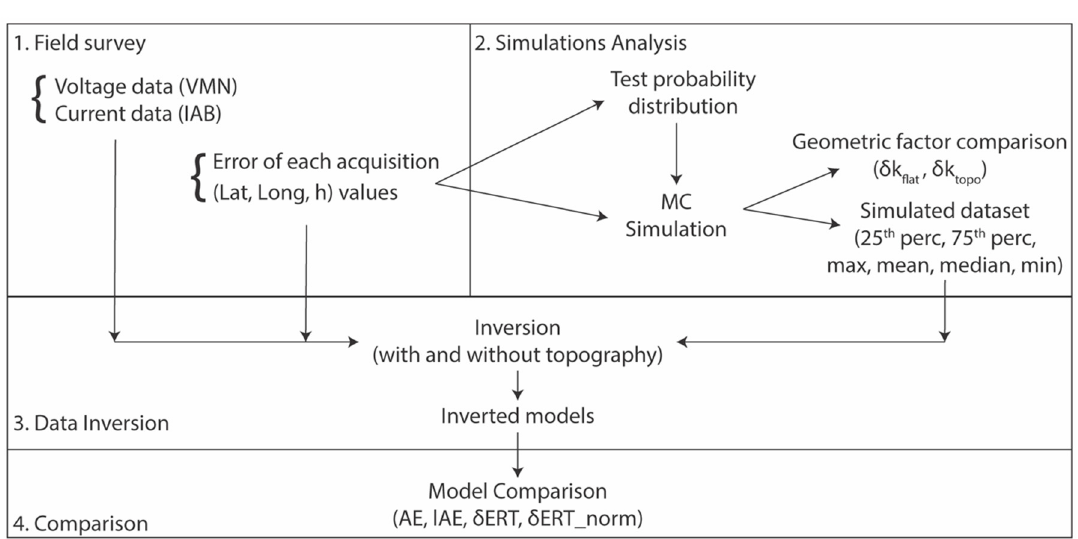
Figure 3. Flow chart of the whole procedure. Four main steps can be identified: 1. The field data acquisition of both electrical soil parameters (“original” data) and geographical coordinates of the electrodes, 2. The MC simulation to take into account the GPS-errors, 3. The “original” and simulated electrical resistivity data inversion with (topo) and without (flat) topography, 4. The models comparison to evaluate the GPS-error influence.